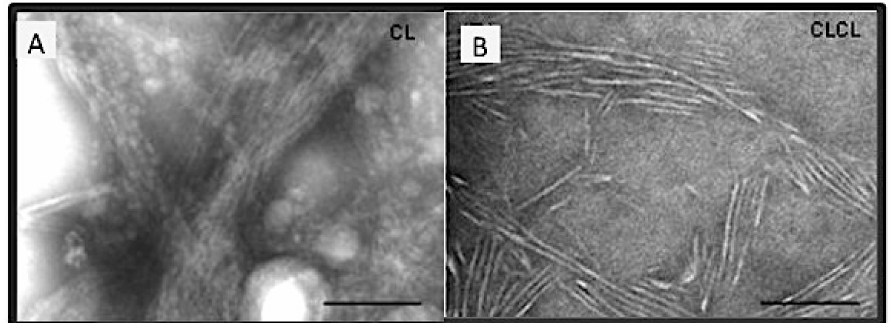
Figure 5. The self-assembled fibrils of CL and CL-CL peptides. ( A ) The mesh-like aggregates of CL. ( B ) The discrete, end-on-end assembly of CL-CL [159]. The scale bars are 100 nm in both pictures. The self-assembly of the axial repeating structure of collagen fibrils indicates the specific D -staggering arrangement representing the most stable conformation during the self-association of the triple helix. Thus, in addition to providing sufficient stability for mutual association, there ought to be a built-in mechanism for conformational bias for the specific staggered structure. This bias was achieved by using recombinant peptides with repeating sequence units (SUs) in its primary structure [13,169]; each SU consists of 123 amino acid residues in an uninterrupted (Gly-X-Y) n repeating sequence. Two collagen mimetic peptides: Col108 and 2U108 with, respectively, 3 and 2 identical SUs arranged in tandem plus a C-terminal overhang region were shown to self-assemble into mini- fibrils with an axial repeating structure of 35 nm as examined using electron microscopy (Figure 6A–D) and AFM [13]. This 35-nm repeating structure of the mini-fibrils consists of a ~15-nm overlap region and 20-nm gap, and is designated the d -period to distinguish it from the 64 nm D -period of natural fibrillar collagen. These mini-fibrils can reach 1 µ m in length with a diameter about 50–70 nm. In a sense it is a self-assembly at an entirely different scale compared to the self-assembled long triple helix of CMPs. Structural analysis and biophysical studies have further indicated that the 35 nm d -period results from the self-assembly of the triple helices with a mutual staggering of 1 SU at the ends, in a way reminiscent to that of the D -staggering of collagen fibrils